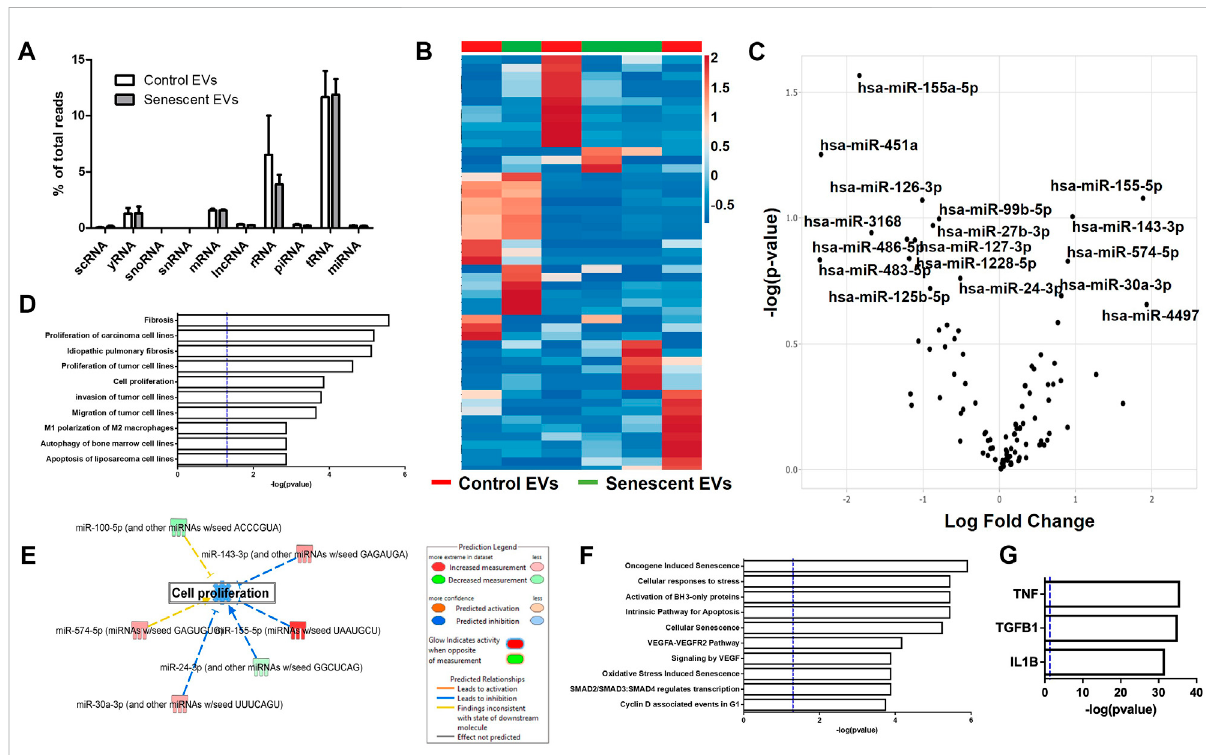
Senescent EVs are characterized by differentially expressed miRNAs. (A) Small RNA sequencing percentage read counts of diverse EV RNA content including snoRNAs, snRNAs, tRNAs, lncRNA, yRNA, scRNA, mRNAs, rRNAs and microRNAs, with tRNAs being the most abundant (N = 6). (B) Heatmap of 50 differentially expressed miRNAs ( p < 0.25). (C) Volcano plot of log fold change versus – log ( p -value) of miRNAs with 17 miRNAs of interest annotated. See Table 1. (D) IPAcanonical pathwayenrichmentanalysis ofmiRNAs. (E) Networkanalysispredictions forcell